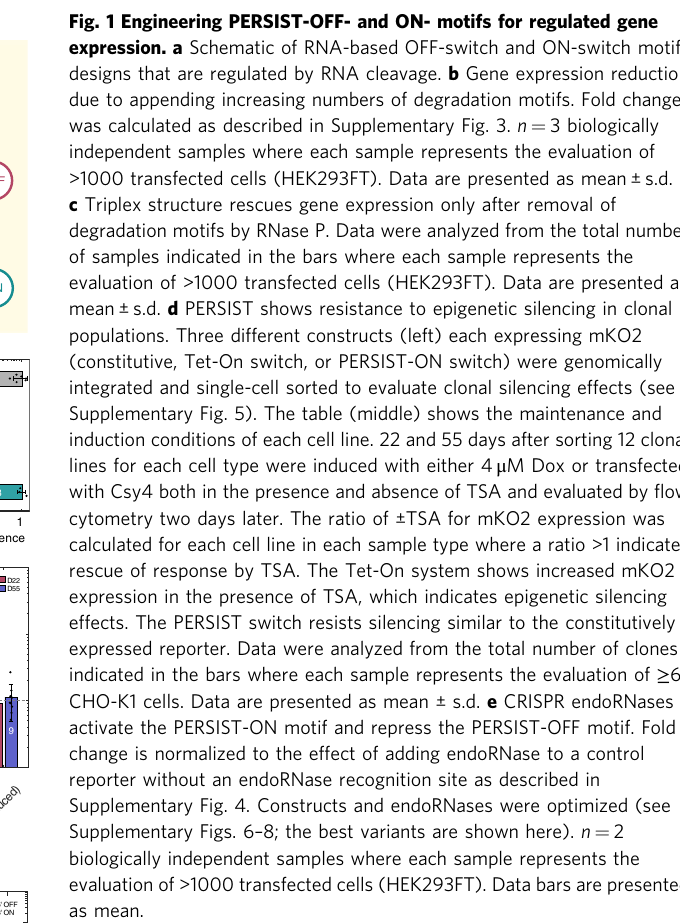
Supplementary Figs. 6 – 8; the best variants are shown here). n = 2 biologically independent samples where each sample represents